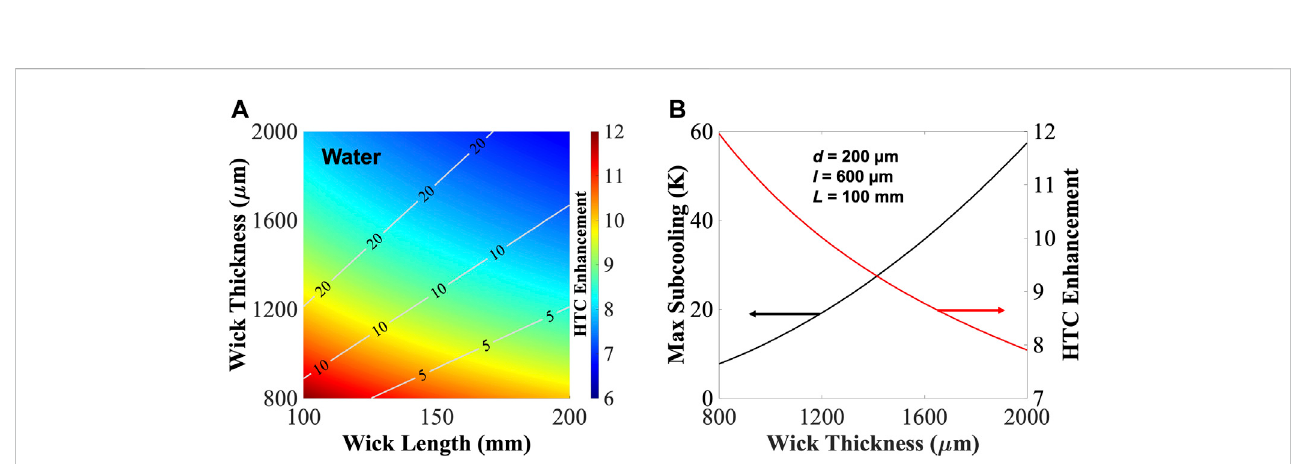
FIGURE 3 (A) Regime map for the HTC Enhancement of water. The color contours represent the HTC Enhancement and the gray contour lines represent the maximum subcooling before condensate fl ooding. (B) Maximum subcooling and HTC Enhancement as functions of the wick thickness for a wick length of 100 mm. The geometry of the pillar array is d = 200 μ m, l = 600 μ m, and the condensate temperature is 30 °